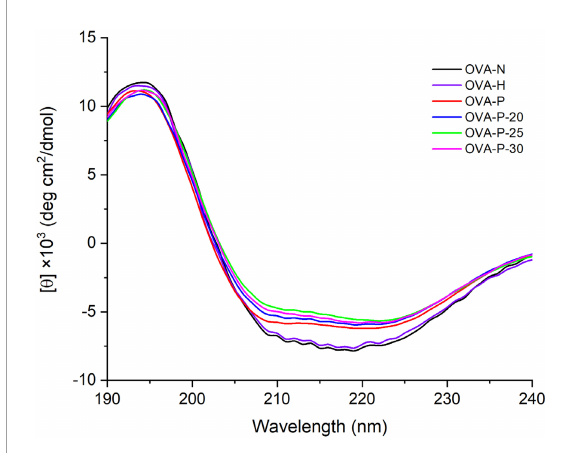
FIGURE3 Changes in far-ultraviolet (UV) circular dichroism (CD) spectra of the ovalbumin (OVA)